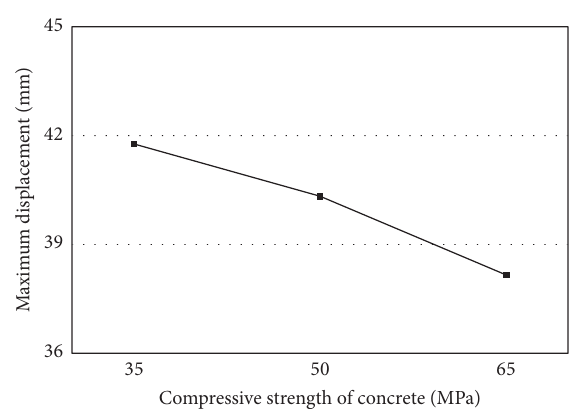
Figure 10: Effect of compressive strength of concrete on displace-